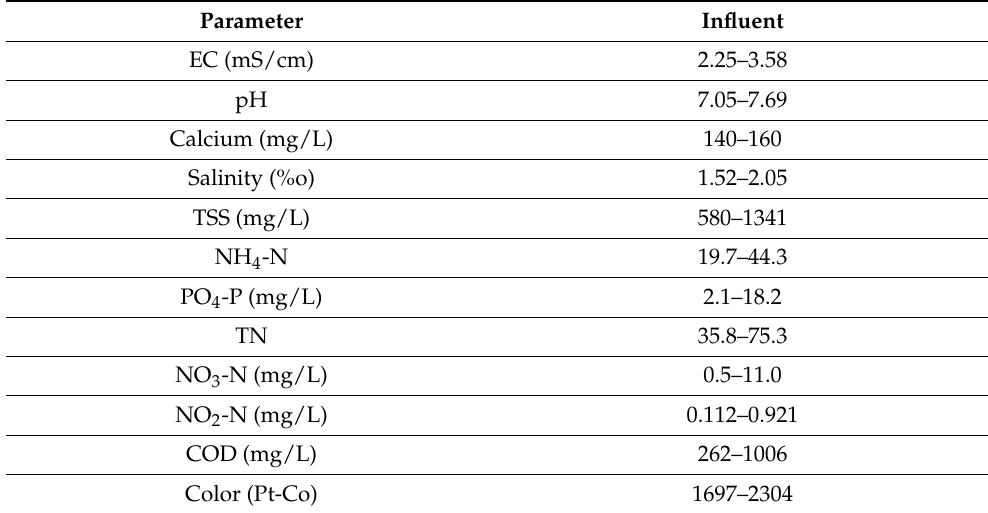
Table 1. Physicochemical characteristics of MBR